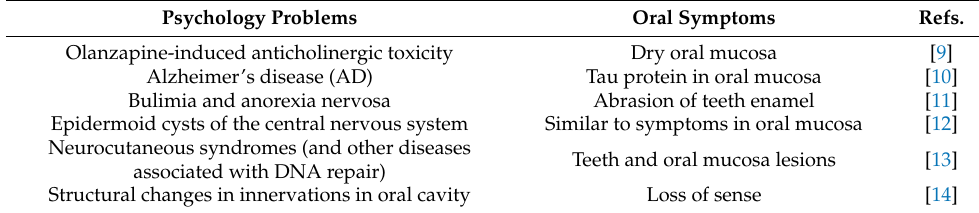
Table 1. Oral symptoms involved in psychological problems.